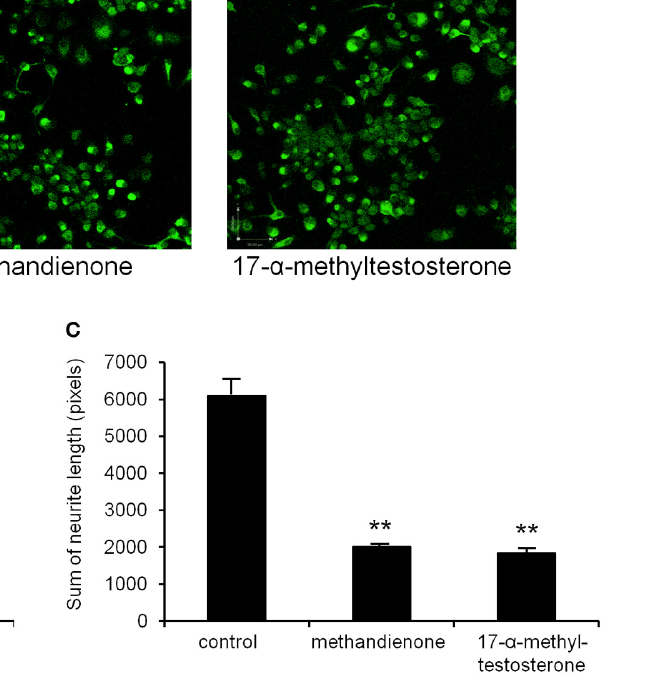
FIGURE 2 | Immunofluorescence for neurofilament to demonstrate neurite outgrowth in PC12 cells differentiated in NGF in tissue culture, either control treated ( left panel ), treated with 75 μ M methandienone ( center panel ) or treated with 75 μ M of 17- α -methyltestosterone ( right panel ) (A). Quantification of neurite outgrowth in the three conditions shown in (A) , as determined by cells exhibiting neurites equal to or greater than the length of one cell body,